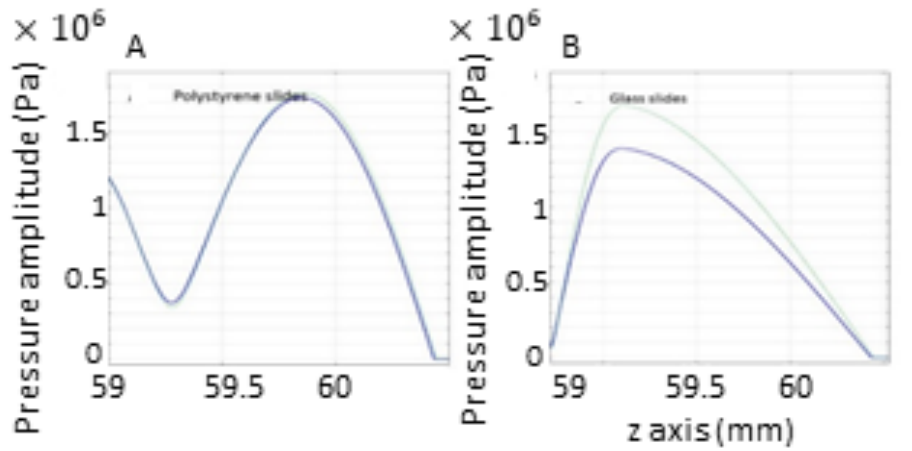
Figure A3. Absolute pressure amplitude along the z-axis depending on the distance between the slides (10 µ m is the dark blue curve or 20 µ m is the light blue curve). ( A ) Absolute pressure when the two slides are in polystyrene. ( B ) Absolute pressure when the two slides are in glass. Since graphs are displayed with an identical scale, glass transmits less power than polystyrene.